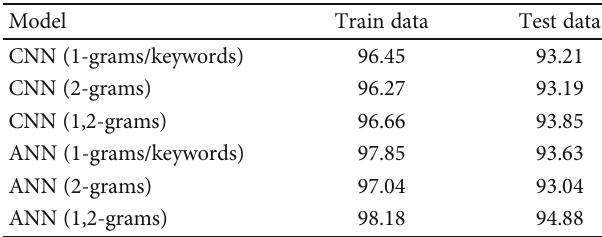
Table 2: Classi fi cation accuracy based on di ff erent